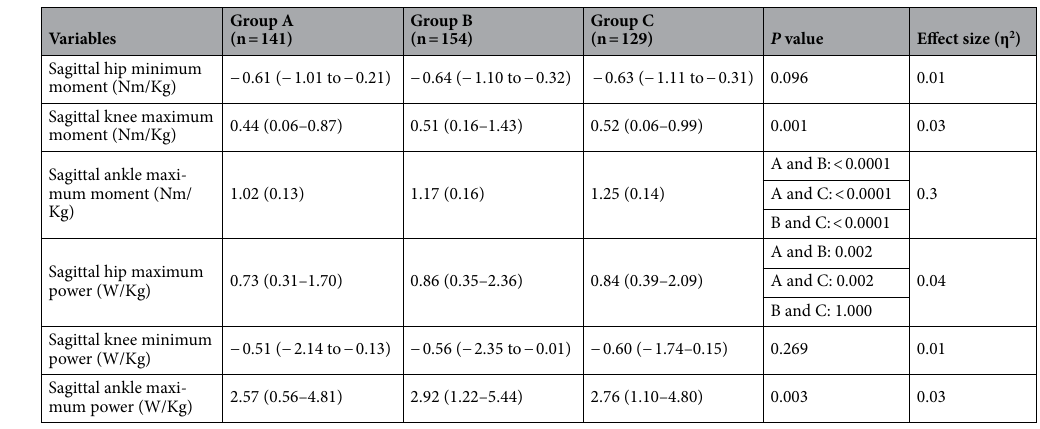
Table 6. The minimum and maximum values for the kinetics of the lower extremity for the three age groups (n = 424). Group A (6–8 years), Group B (9–10 years), Group C (11–12 years). The moment values denote the minimum or maximum moment during the gait cycle. The power values denote the minimum or maximum power over the gait cycle. Units: moment: Nm/kg; power: W/kg. Negative values for hip moments indicate flexion moments. Negative values for power indicate absorption. Differences between the three groups were analyzed using the Kruskal–Wallis test or one-way analysis of variance. Variables with significant differences were subsequently compared using multiple comparison analyses with Bonferroni correction. Data are presented as means (standard deviation) or median values (range). P values < 0.0001 were considered statistically